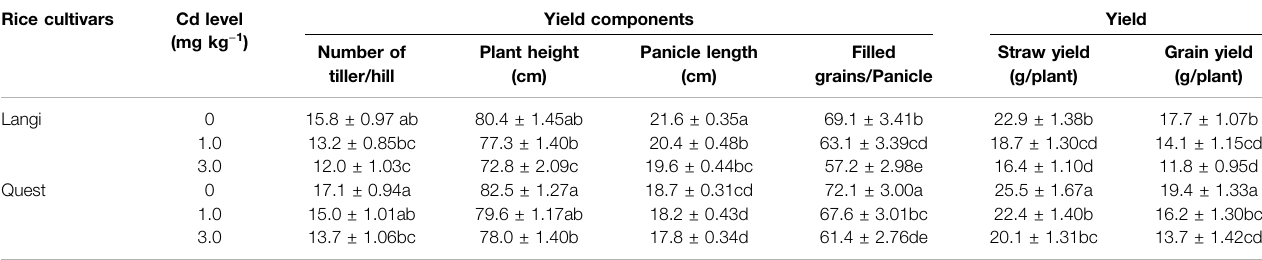
TABLE 3 | Effect of Cd addition in soil on yield components and yield of rice cultivar. Rice cultivars